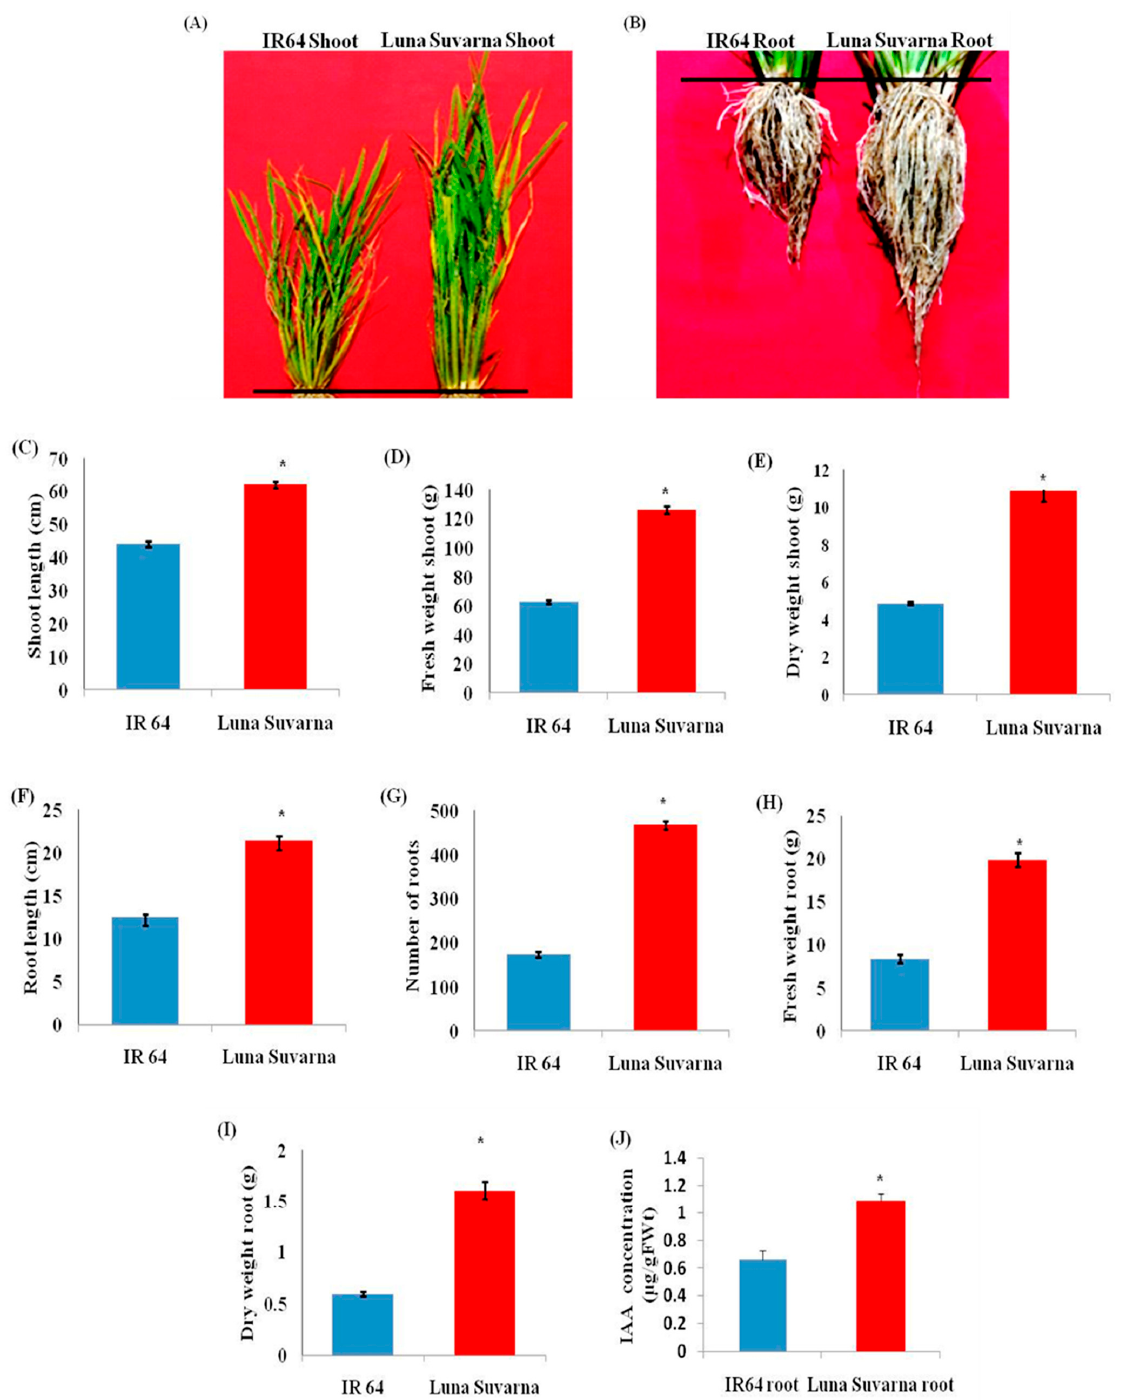
Figure 1. ( A ) Growth response of IR64 and Luna Suvarna (LS) shoot under control conditions; ( B ) Growth response of IR64 and Luna Suvarna (LS) roots under control conditions; ( C ) Comparative analysis of shoot length in IR64 and Luna Suvarna; ( D ) Comparative analysis of the fresh weight of shoot in IR64 and Luna Suvarna; ( E ) Comparative analysis of the dry weight of shoot in IR64 and Luna Suvarna; ( F ) Comparative analysis of root length in IR64 and Luna Suvarna; ( G ) Comparative analysis of the number of roots in IR64 and Luna Suvarna; ( H ) Comparative analysis of the fresh weight of roots in IR64 and Luna Suvarna; ( I ) Comparative analysis of the dry weight of roots in IR64 and Luna Suvarna; ( J ) IAA estimation in the roots of IR64 and LS. Data represent mean ± SE (n = 15) for the analysis of growth parameters while for IAA quantification mean ± SE (n = 3). Asterisks signs (*) represent values which were significantly different among different samples (Fisher LSD, p ≤ 0.05). Blue color represents IR64 while red color represents LS